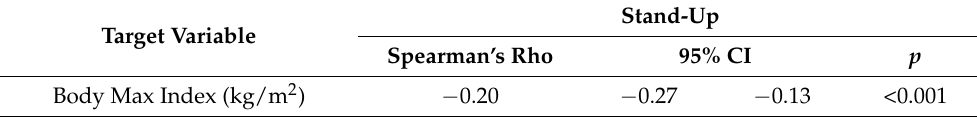
Table 3. Correlation between stand-up test and BMI in older women with